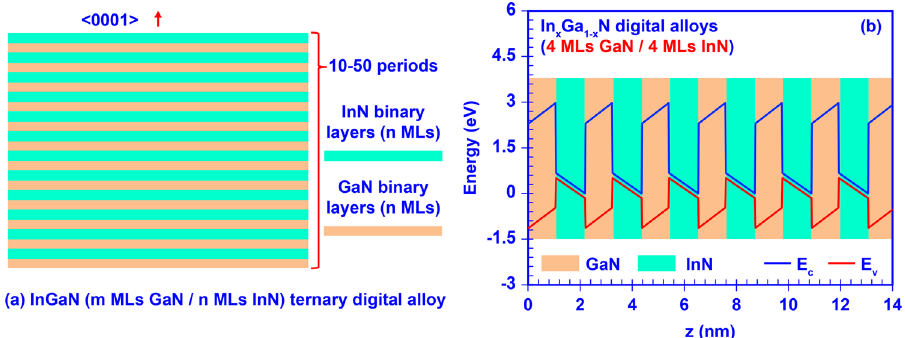
Figure 1. ( a ) Schematic illustration of InGaN digital alloy formed by m MLs GaN and n MLs InN ultra-thin binary layers; ( b ) Band diagram of InGaN digital alloy formed by 4 MLs GaN and 4 MLs InN binary